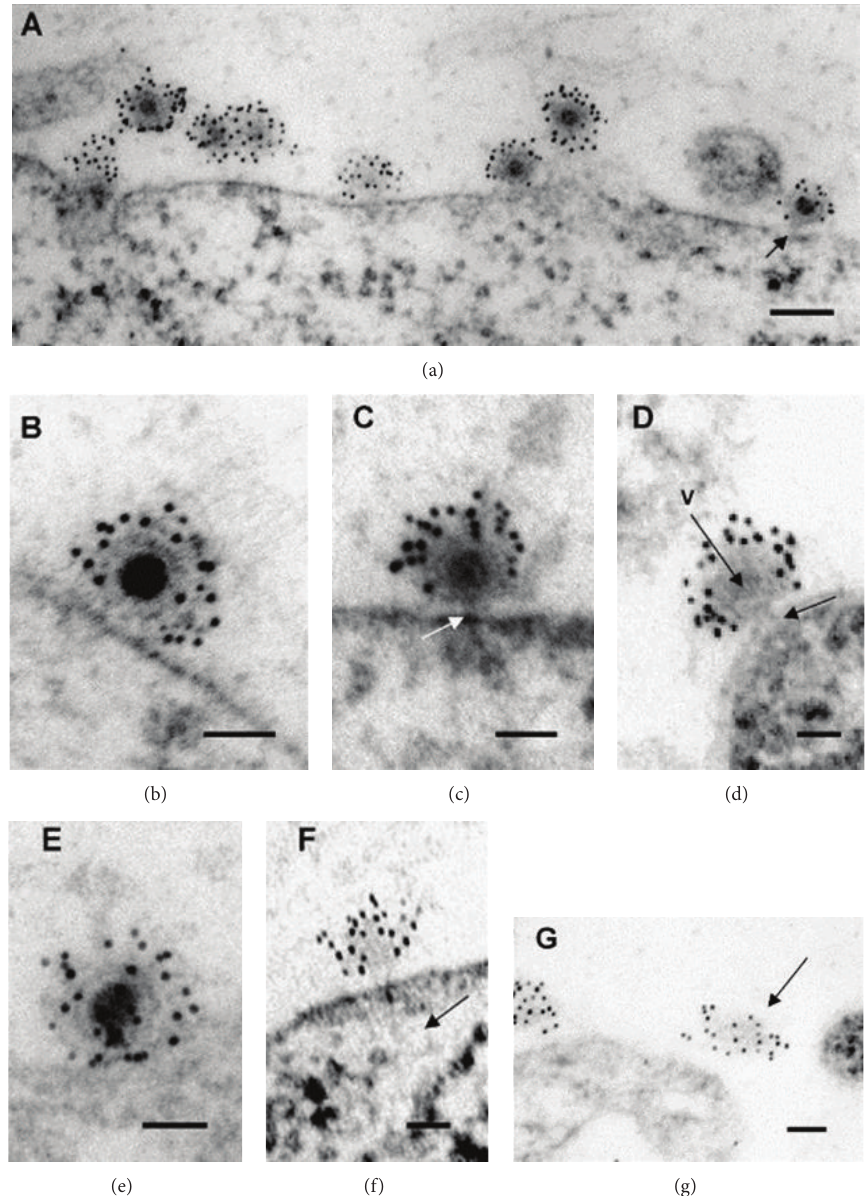
Figure 11: Electron micrographs of thin sections of Sindbis virus-cell complexes at pH 7.2. (a) Low magnification showing “full” and “empty” particles and a particle attached by a pore to the cell surface (arrow). (b) A virion attached to the cell surface before pore formation. (c) A virion with an electron dense core attached to the cell surface by a pore structure (arrow). (d) The pore at the vertex (V) of the protein shell penetrates the cell membrane (arrow). The virion has reduced electron density in the core region. (e) Reorganization of virus RNA into the developing pore. (f) An empty particle with a possible RNA molecule entering the cell (arrow). (g) An empty virion that has lost structure. Magnification scale bar (a) = 1000 ˚A, all others = 500 ˚A. Paredes et at. 2004